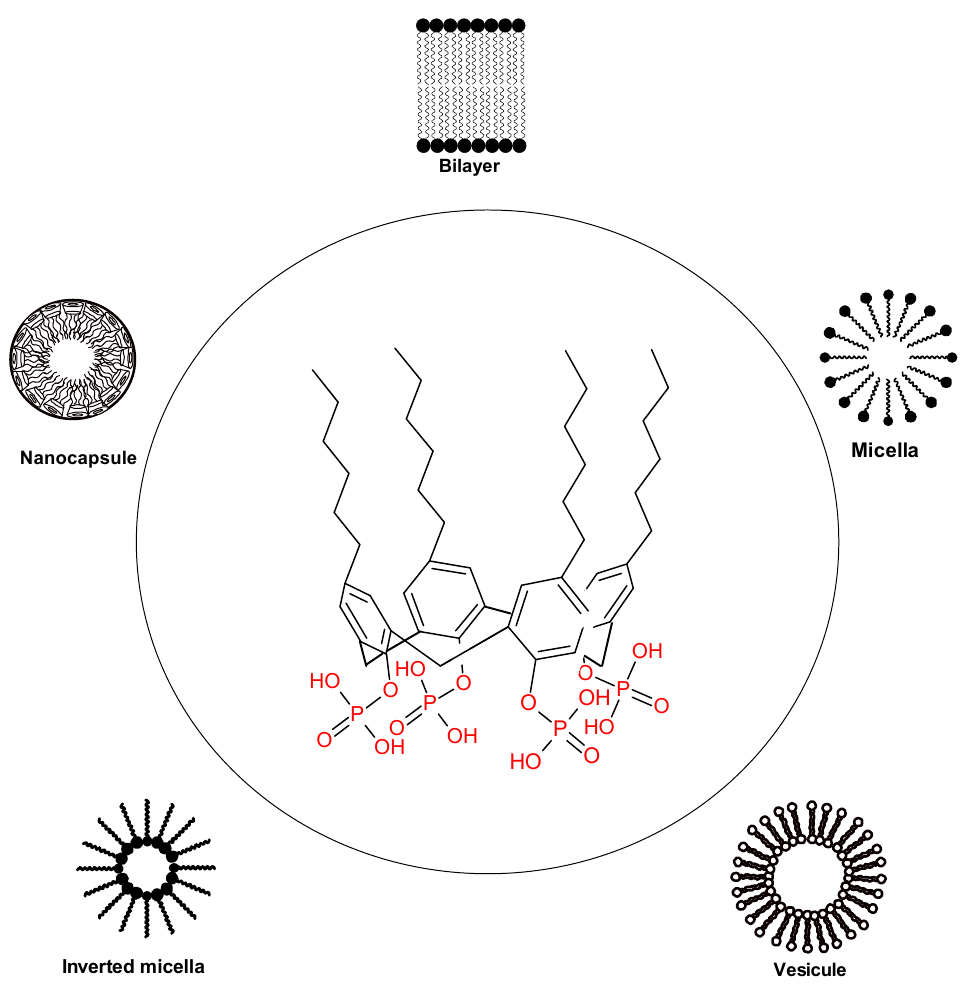
Figure 6. Possibilities of amphiphilic calixarenes in self-assembly.